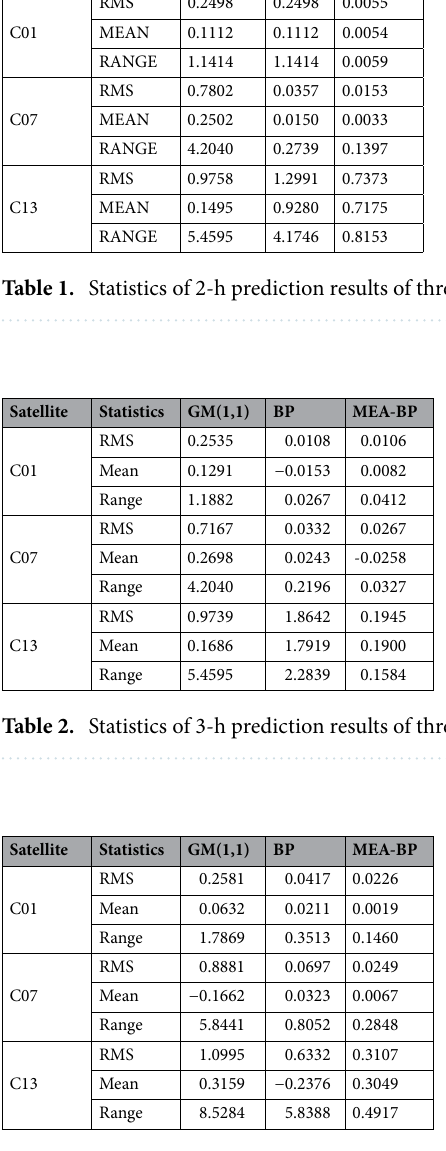
Table 3. Statistics of 6-h prediction results of three satellites (unit: ns).